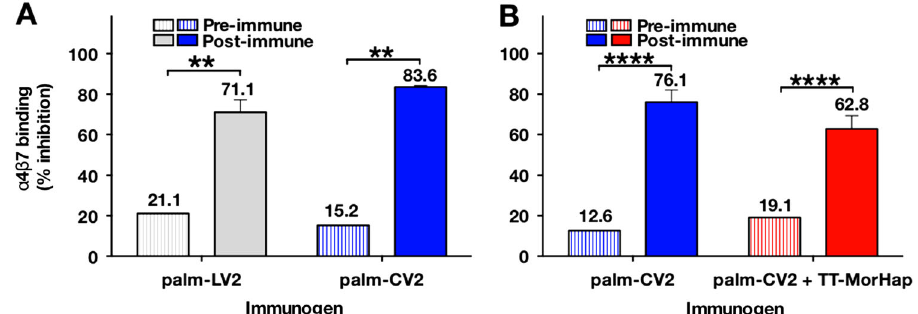
Fig. 5 Inhibition of α 4 β 7 binding to CV2 peptide by immune sera. a Mice (six per formulation) were immunized with palm-LV2 or palm-CV2 and bled at week 9. b Mice (ten per formulation) were immunized either with palm-CV2 or with palm-CV2+TT-MorHap, and were bled at week 15. The average % inhibition induced by immunization with palm-CV2 for the two animal studies was 80%. Values are mean ± SEM. Asterisks indicate signi fi cant difference between pre-immune and post-immune sera using a Mann – Whitney t test (** p < 0.01; **** p < 0.0001)